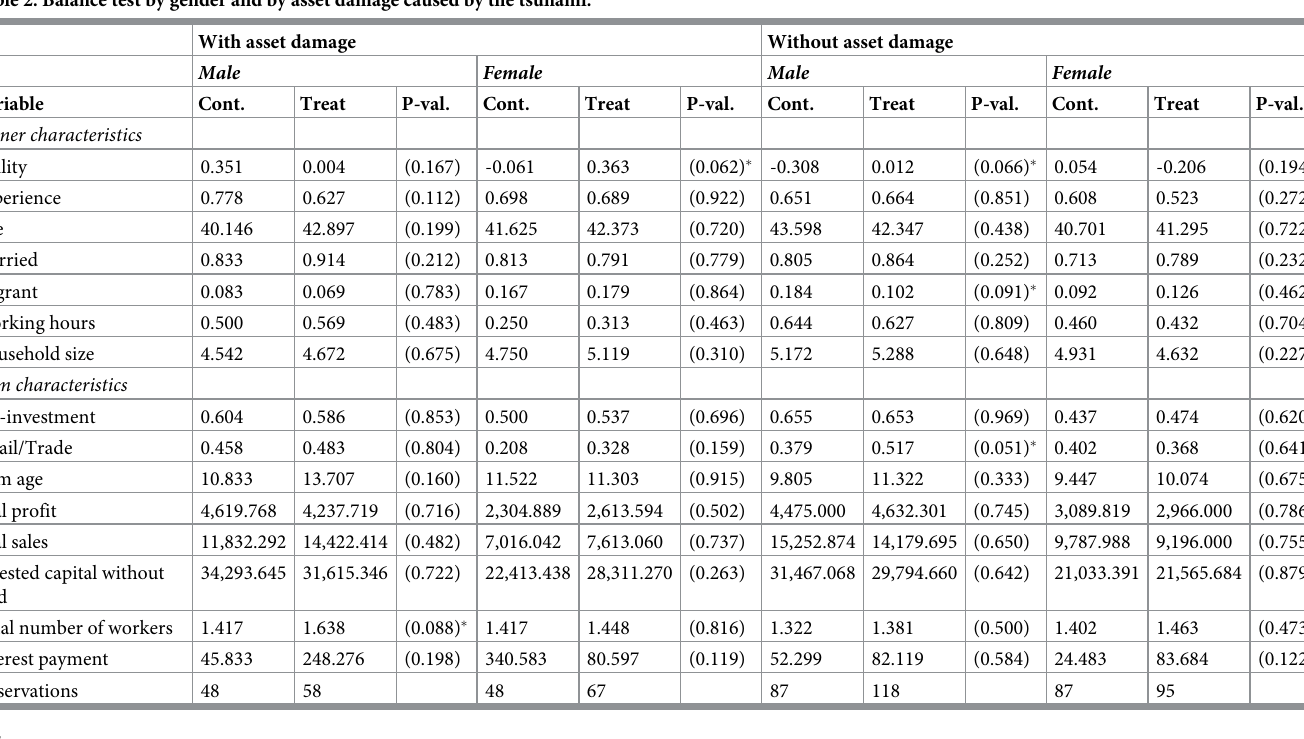
Table 2. Balance test by gender and by asset damage caused by the